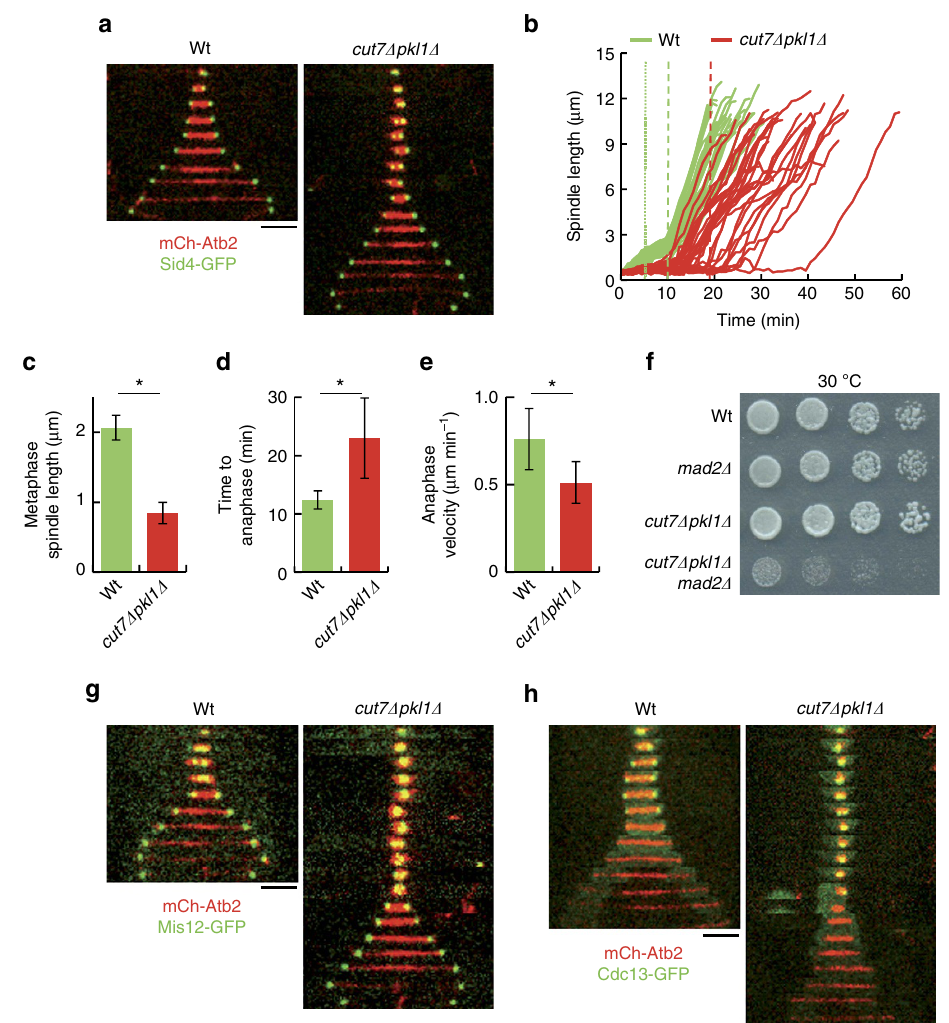
Figure 1 | cut7 D pkl1 D cells assemble a functional spindle. ( a ) Time-lapse images of wild-type (wt) and cut7 D pkl1 D cells expressing mCherry-Atb2 (tubulin) and Sid4-GFP (spindle pole marker) from mitosis onset to spindle breakdown. Each frame corresponds to 3min interval. ( b ) Comparative plot of spindle length dynamics of wild-type (green curves; n ¼ 19) and cut7 D pkl1 D cells (red curves; n ¼ 24). Dotted vertical line corresponds to phase I–II transition; dashed vertical line corresponds to phase II–III transition. ( c ) Bar plot showing metaphase spindle length at anaphase transition, reported by Cdc13-GFP degradation, of wild-type (green; n ¼ 15) and cut7 D pkl1 D cells (red; n ¼ 24). * P o 0.001. ( d ) Bar plot showing the time to anaphase transition in wild-type (green; n ¼ 15) and cut7 D pkl1 D cells (red; n ¼ 24). * P o 0.001. ( e ) Bar plot showing anaphase spindle elongation velocity of wild-type (green; n ¼ 29) and cut7 D pkl1 D cells (red; n ¼ 22). * P o 0.001. ( f ) Serial dilution (fourfold) assay showing the genetic interaction of mad2 D with the cut7 D pkl1 D strain. Plates were incubated 2–3 days at the specified temperatures. ( g ) Time-lapse images of wild-type (wt) and cut7 D pkl1 D cells expressing mCherry-Atb2 and Mis12-GFP (kinetochore marker) from mitosis onset to spindle breakdown. Each frame corresponds to 3min interval. ( h ) Time-lapse images of wild-type (wt) and cut7 D pkl1 D cells expressing mCherry-Atb2 and Cdc13-GFP (cyclin B) from mitosis onset to spindle breakdown. Each frame corresponds to 3min interval. Data show mean ± s.d. and Student’s t -test P value. Scale bars, 2 m